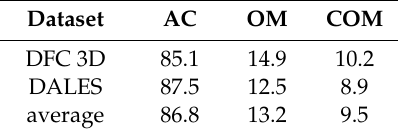
Table 7. Individual tree segmentation results of the DFC 3D and DALES datasets using our method (All values are in